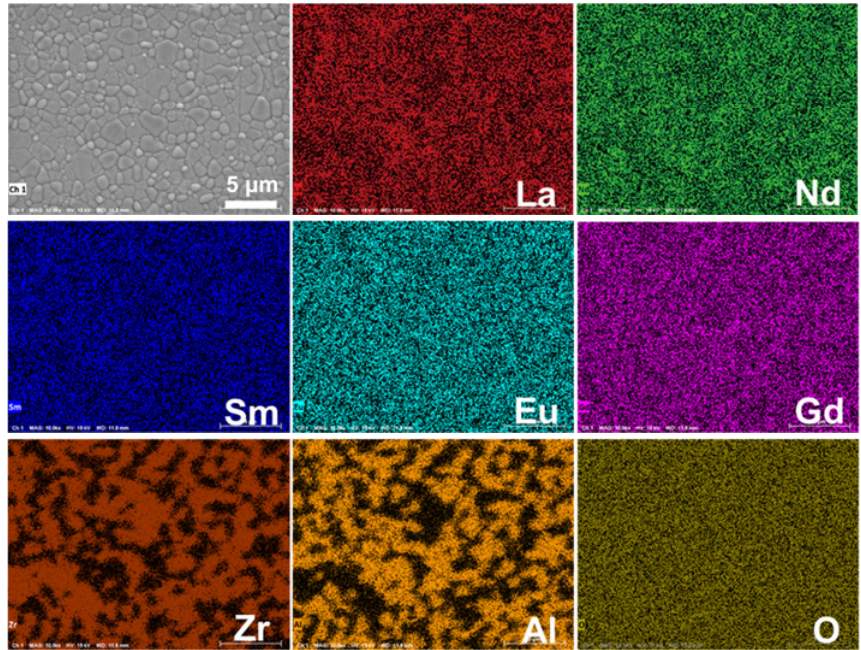
Fig. 4 Energy dispersive spectroscopy (EDS) elemental distribution mappings of HEAO–50%HEZO particulate